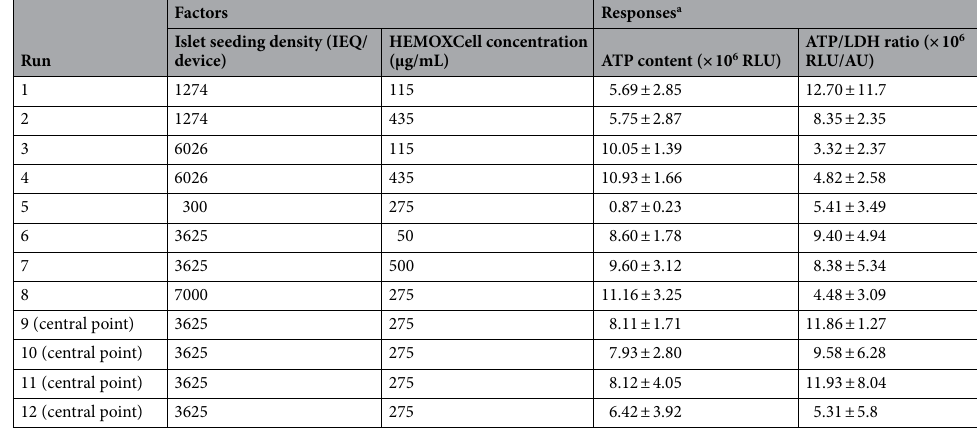
Table 4. Factorial design matrix and experimental results obtained for the optimization DoE. a Mean of five independent experiments.